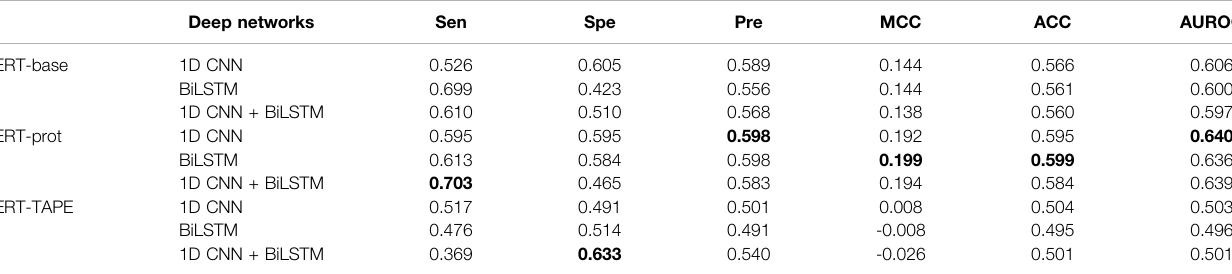
TABLE 3 | Cross-validation performance of models based on embeddings of the central “ average ” extracted from different pretrained BERT models. Deep networks Sen Spe Pre MCC AUROC